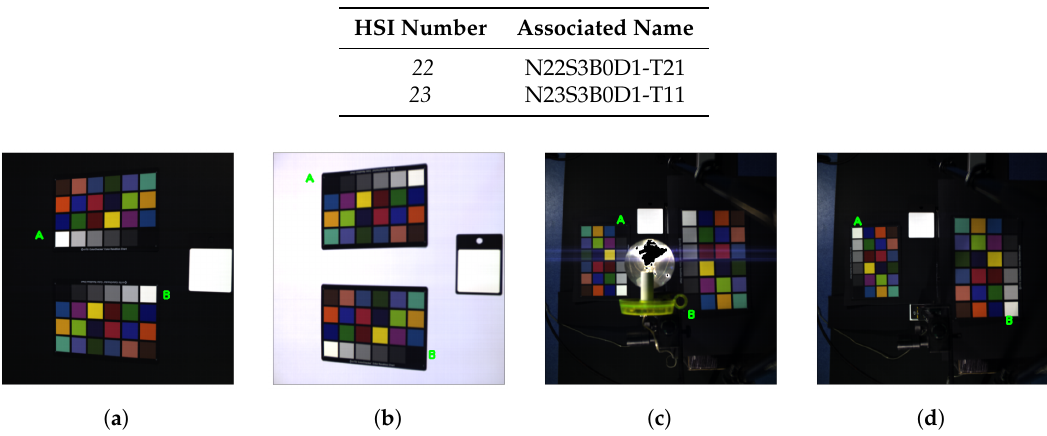
Table 4. Names are coded using the pattern N·S·B·D·-T· where S identifies the setup (3), B the background (black, white), D the position of the gray-scale rows (toward center or toward border) and T the integration time.